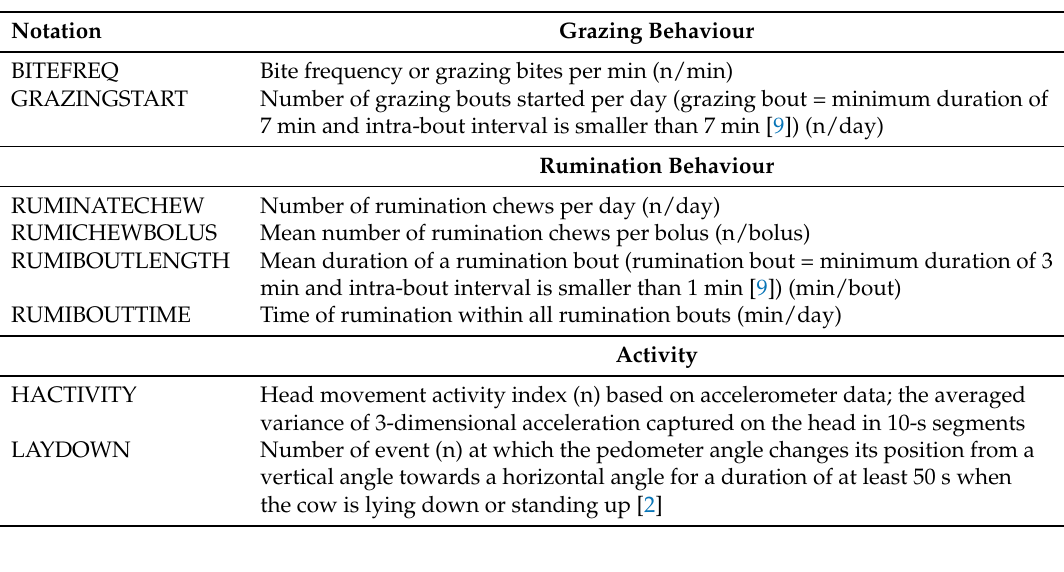
Table 1. List of feeding behaviour and activity related variables used in the classification models.